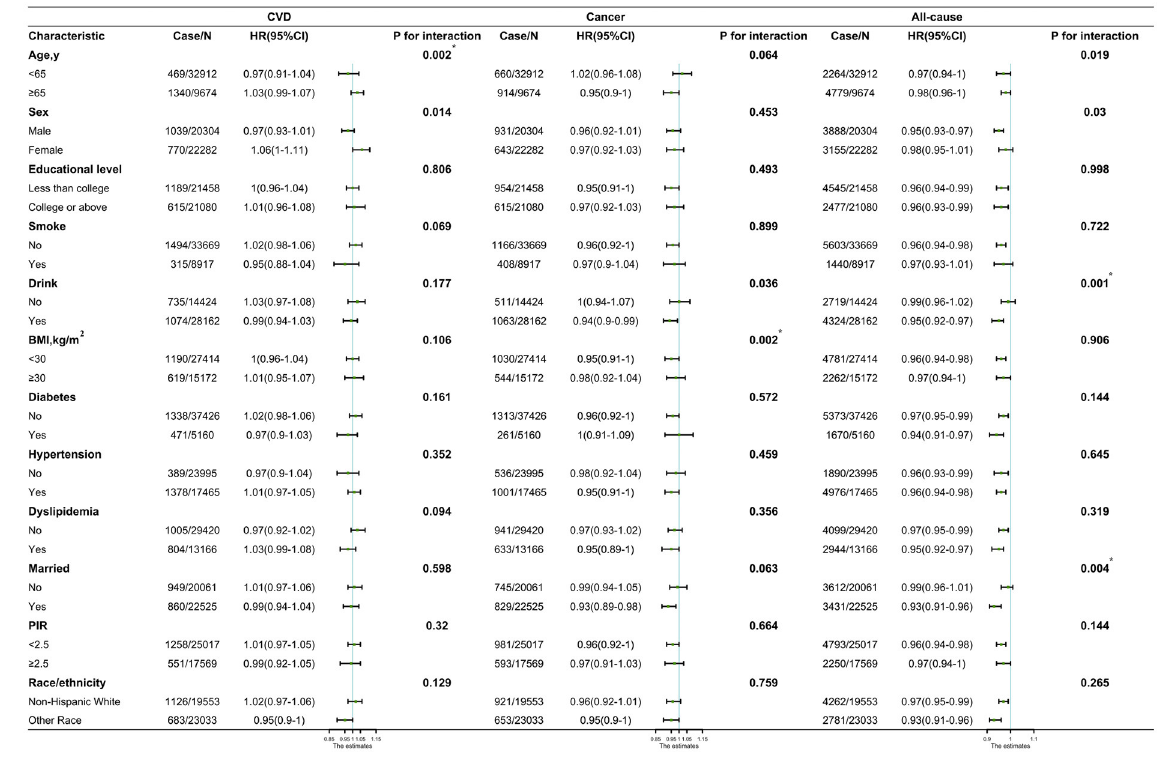
(diabetes, hypertension, dyslipidemia, and CVD) increased and the proportion of participants with cancer